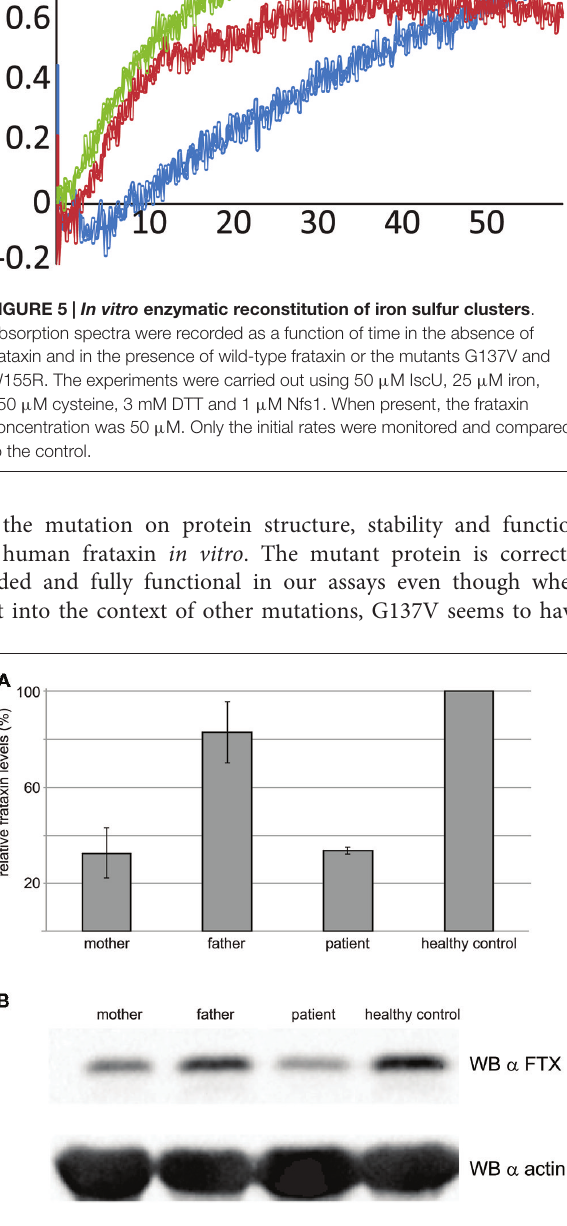
FIGURE 6 | Western blot results to probe the frataxin levels in the blood. (A) Total cell extracts were resolved on SDS–PAGE and analyzed with anti-frataxin antibody, or anti-actin, as a loading control. The graph represents relative mean frataxin abundance as quantitated by densitometric analysis of three technical replicates from two different experiments, normalized with actin levels. Error bars represents standard deviation of the mean. (B) Representative western blot analysis out of three performed with similar results, is